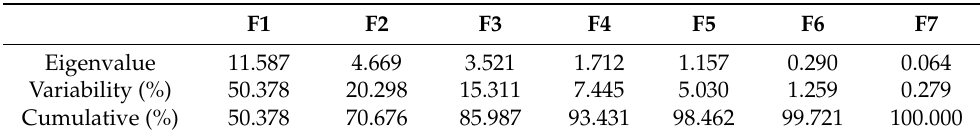
Table 4. PCA: eigenvalue, percentage of variance, and cumulative percentage of principal compo- nents